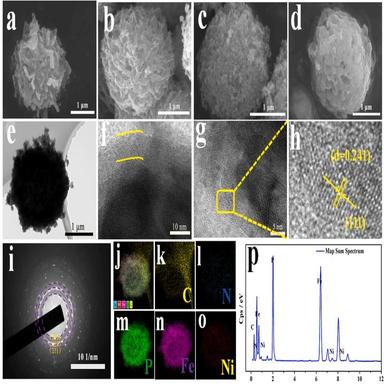
FESEM images of Pre-NiFe (a); Pre-NiFe@C (b); Ni-Fe2O3@C (c) and Ni-FeP@C (d), TEM images of Ni-FeP@C (e and f), HRTEM images of Ni-FeP@C (g and h), SAED pattern of Ni-FeP@C (i), HAADF-STEM and element (C, N, P, Fe, Ni) images of Ni-FeP@C (j-o), EDS spectra of Ni-FeP@C (p).